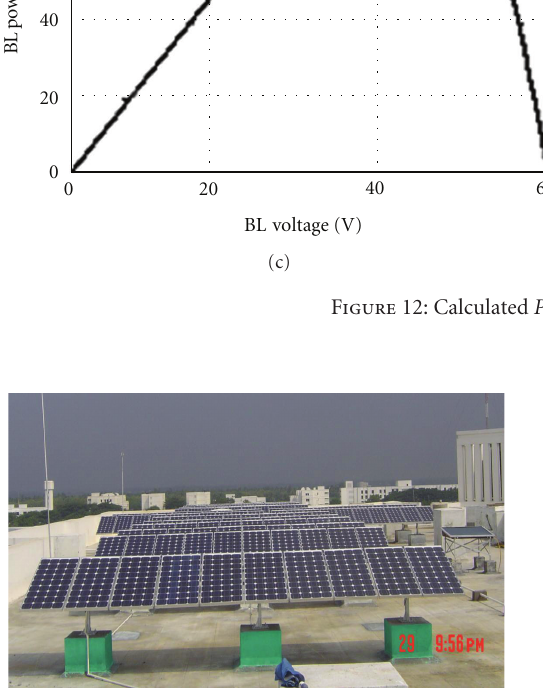
Figure 13: 10 kW SPVA (14 × 10) installed in open terrace of EEE department block by SSNRC (BELL